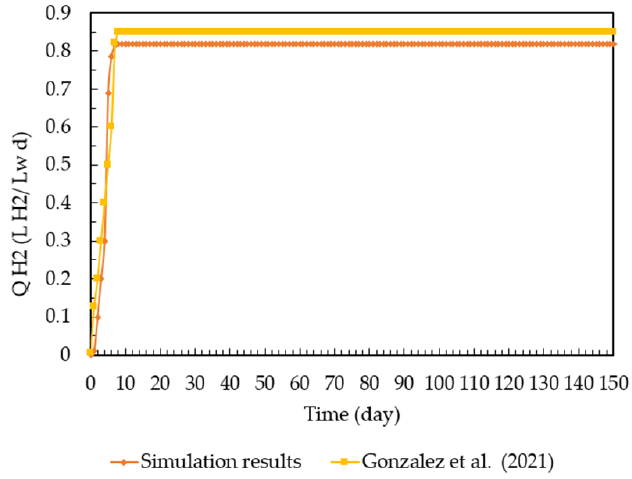
Figure 5. The daily hydrogen production rate (MDEC) per litre of wastewater [5].